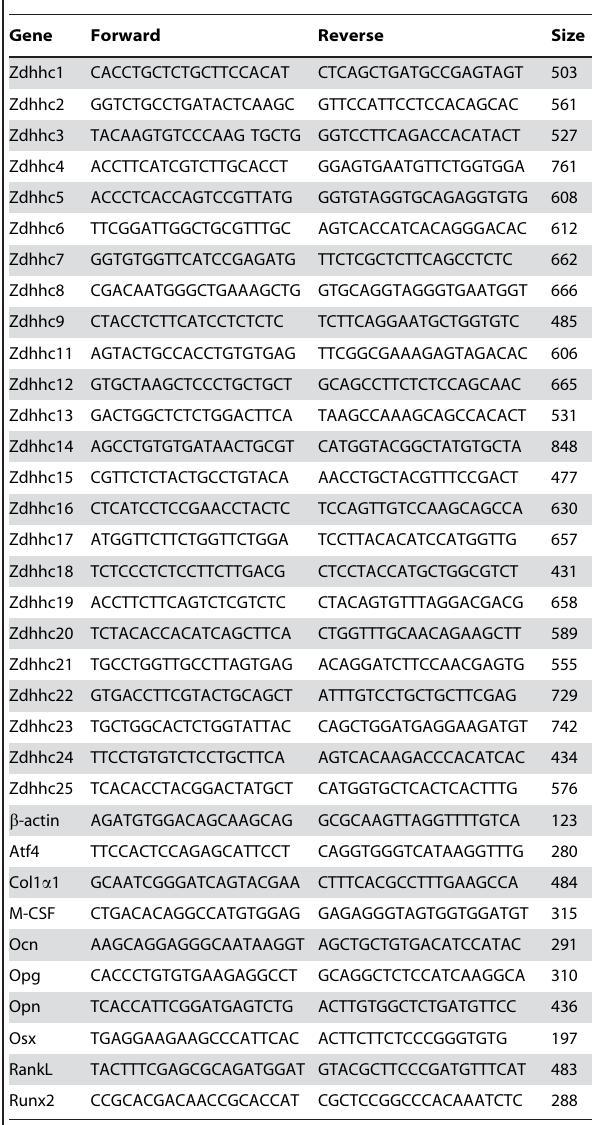
Table 1. The primer sequences for the 24 mouse PATs and other genes studied here and the sizes of the PCR